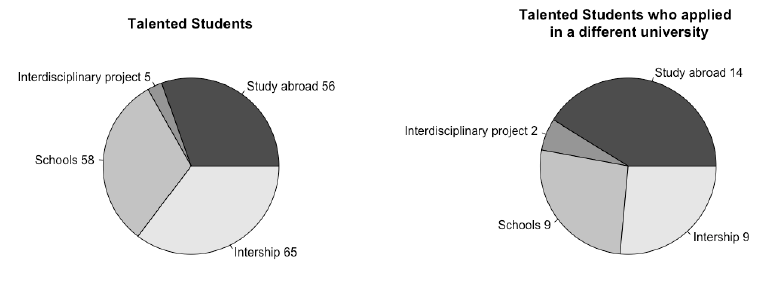
Fig. 6. Analysis of third-year activities selection by the overall talented students (right) and the ones that applied in a different university